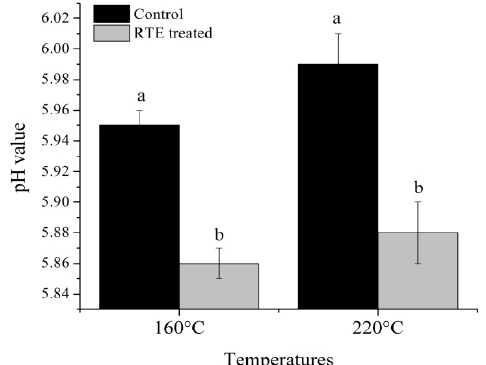
Figure 3. Effects of the Rosa rugosa tea extract (RTE) on the cooking loss; means ± SD of triplicate analyses; means bearing different letters (a, b) between control and RTE treated groups of single temperature indicate significant difference ( p < 0.05).